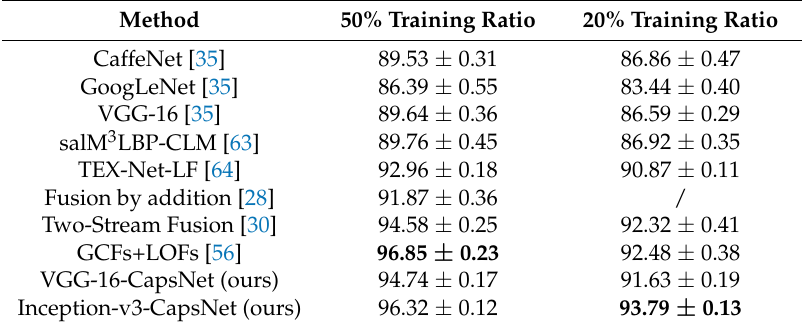
Figure 15. Confusion matrix of the proposed method on UC Merced Land-Use dataset by fixing the training ratio to 50%. Table 2. Overall accuracy (%) and standard deviations of the proposed method and the comparison methods under the training ratios of 50% and 20% on the AID